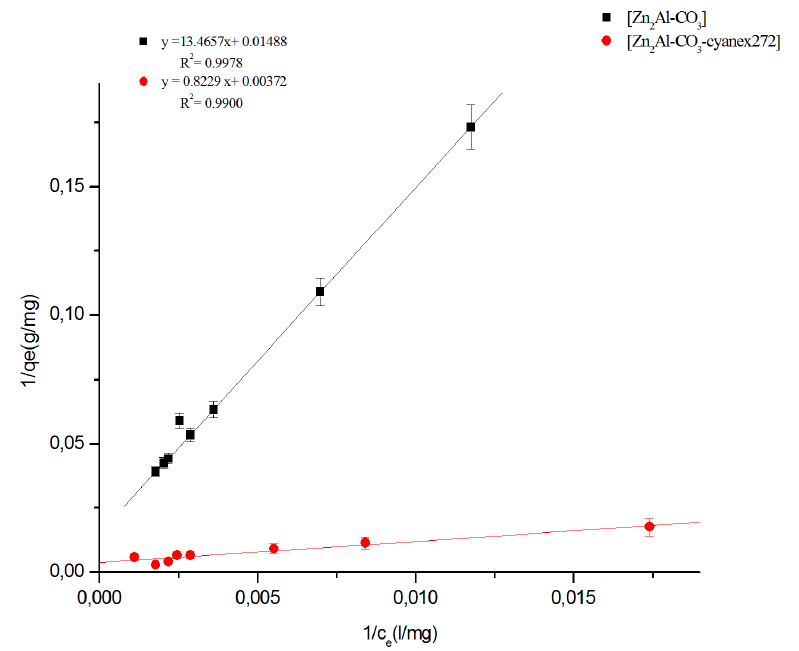
Figure 12. Langmuir isotherm of Zn(II) extraction.